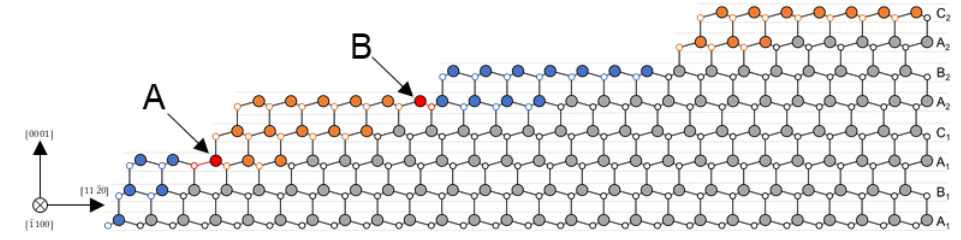
Figure 5. Illustration of the step-flow growth mode which is controlled by step bunching.